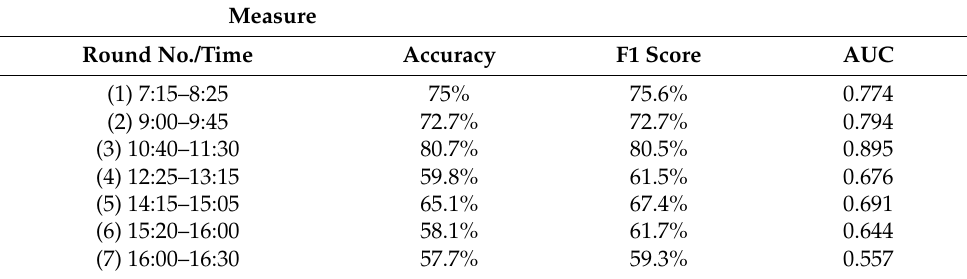
Table 12. Performance for each round of the diurnal measurements.